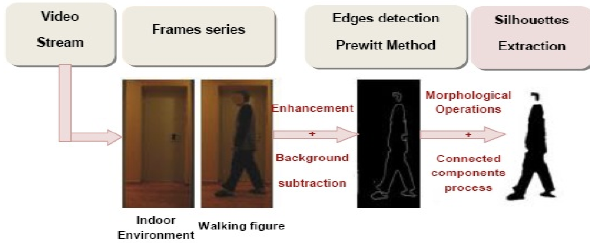
Figure 4: steps of the image processing method